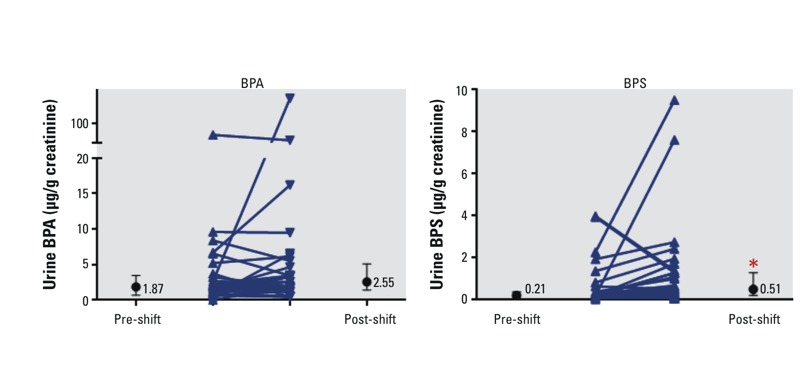
Pre- and post-shift urinary levels of BPA and BPS: individual patterns and group median. Error bars for the group medians indicate the 25–75% range.
*p < 0.001, significant difference between pre-shift and post-shift.